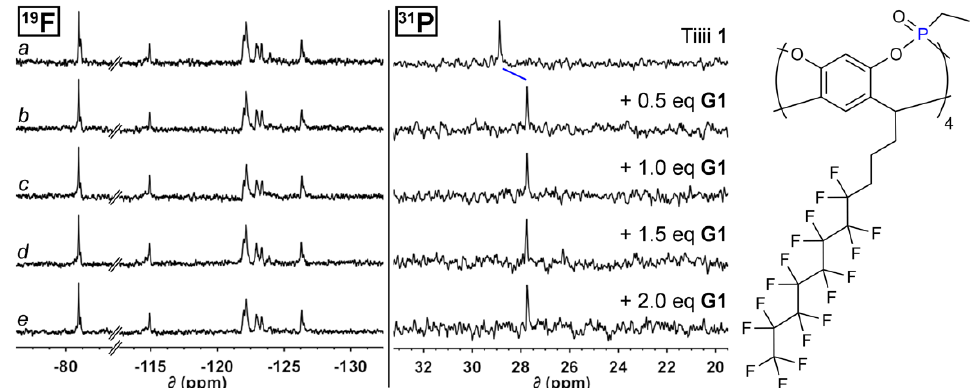
Figure 1. 19 F (376 MHz, CDCl 3 , 298 K) and 31 P NMR (162 MHz, CDCl 3 , 298 K) spectra of free host 1 ( a ), 1 + 0.5 eq. of G1 ( b ), 1 + 1.0 eq. of G1 ( c ), 1 + 1.5 eq. of G1 ( d ), 1 + 2.0 eq. of G1 ( e ); on the right cavitand 1 structure is reported.